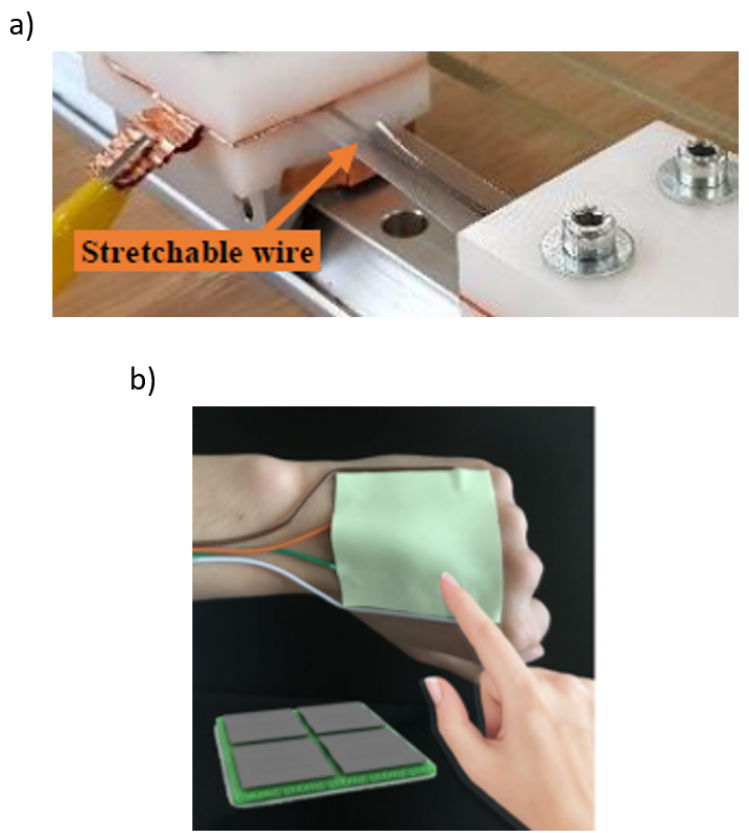
Figure 10. Comparison between ( a ) inkjet-printed wiring [148] and ( b ) conventional wiring